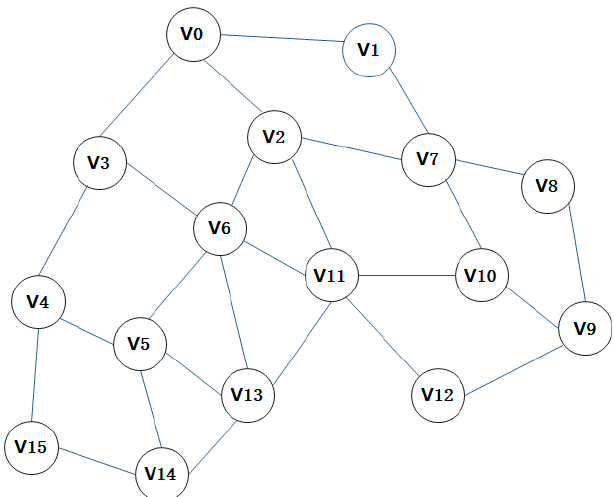
Figure 7. Simulate the network connection of inter-satellite nodes.